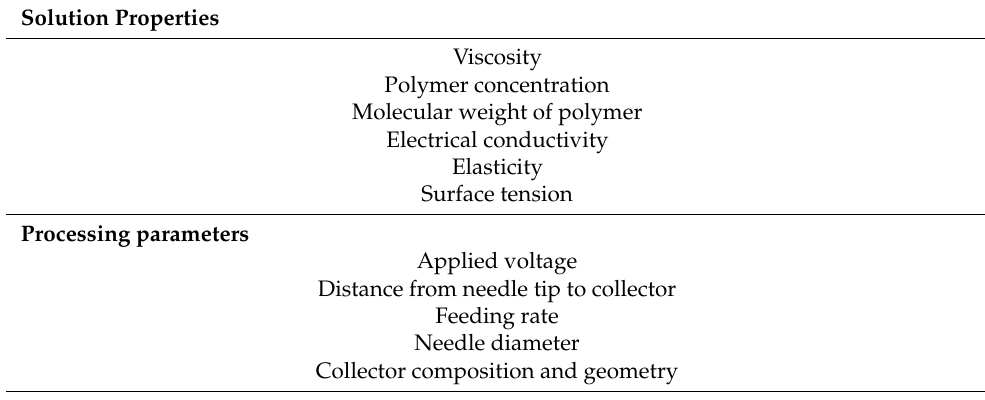
Table 1. The Xs set—material and processing parameters in electrospinning (adapted from